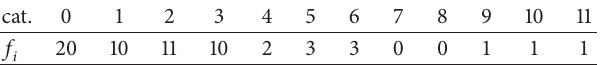
Table 3: Empirical frequency distributions for the first example dataset.